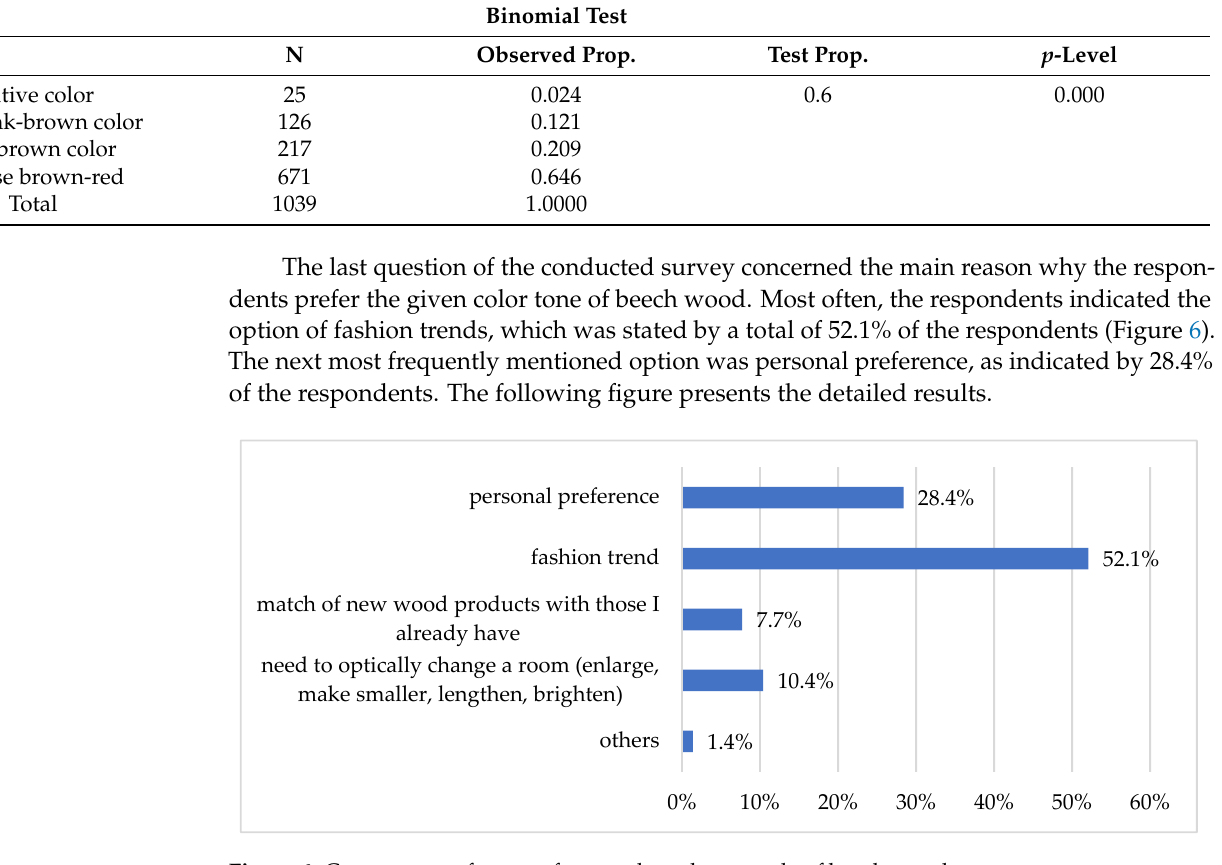
Figure 6. Consumer preferences for wood products made of beech wood.